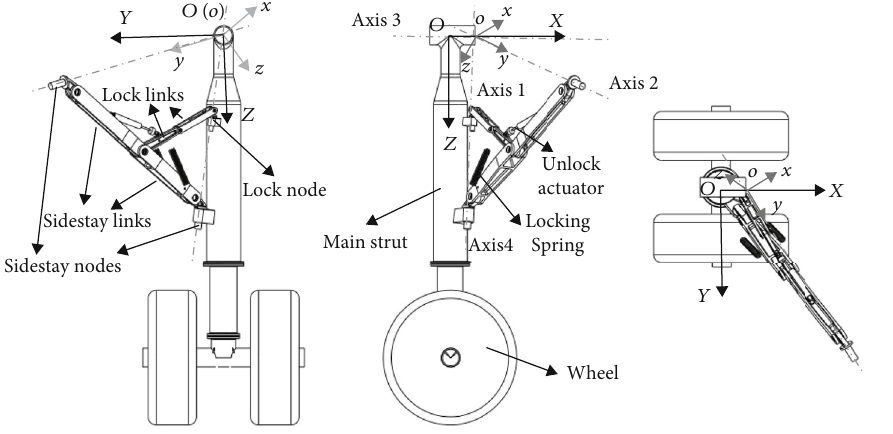
Figure 3: A certain 3D landing gear